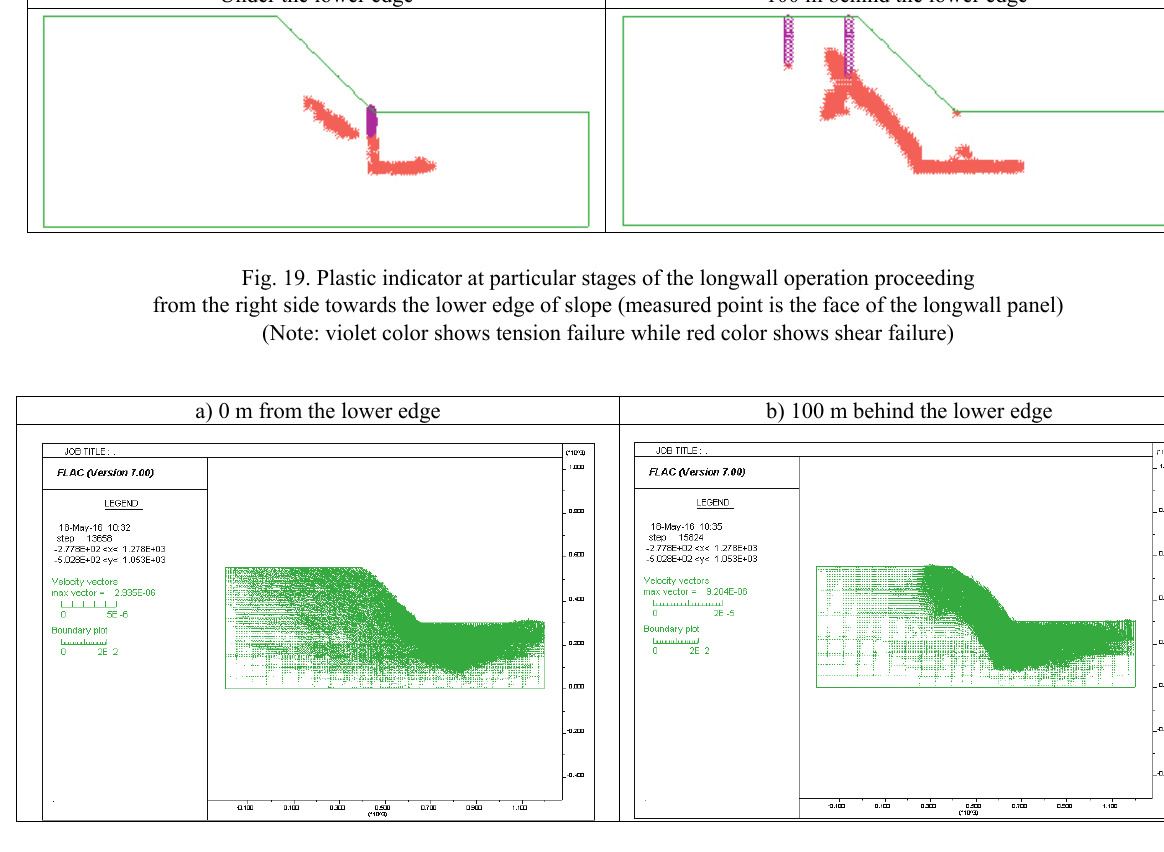
Fig. 20. Velocity vectors at particular stages of the longwall operation proceeding from the right side toward the lower edge of slope (measured point is the face of the longwall